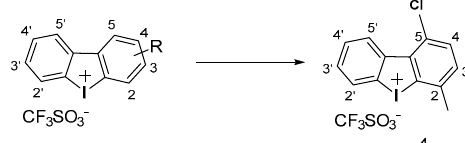
Figure 7. Chemical structures of DPI and compound 4.